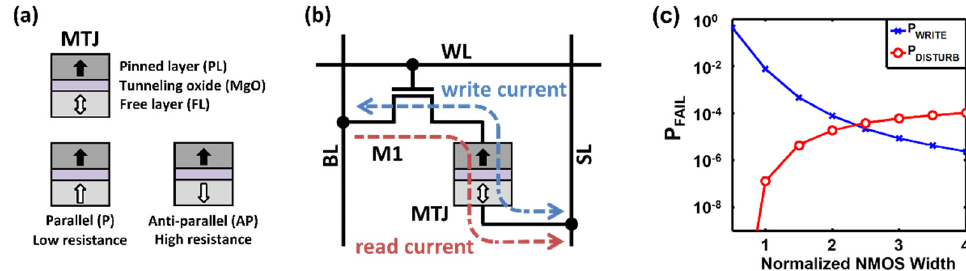
Figure 1. ( a ) Device structure for MTJ, ( b ) STT-MRAM bit cell structure, ( c ) probability of read-disturb failure and write failure, with respect to the normalized width of the access transistor [13].